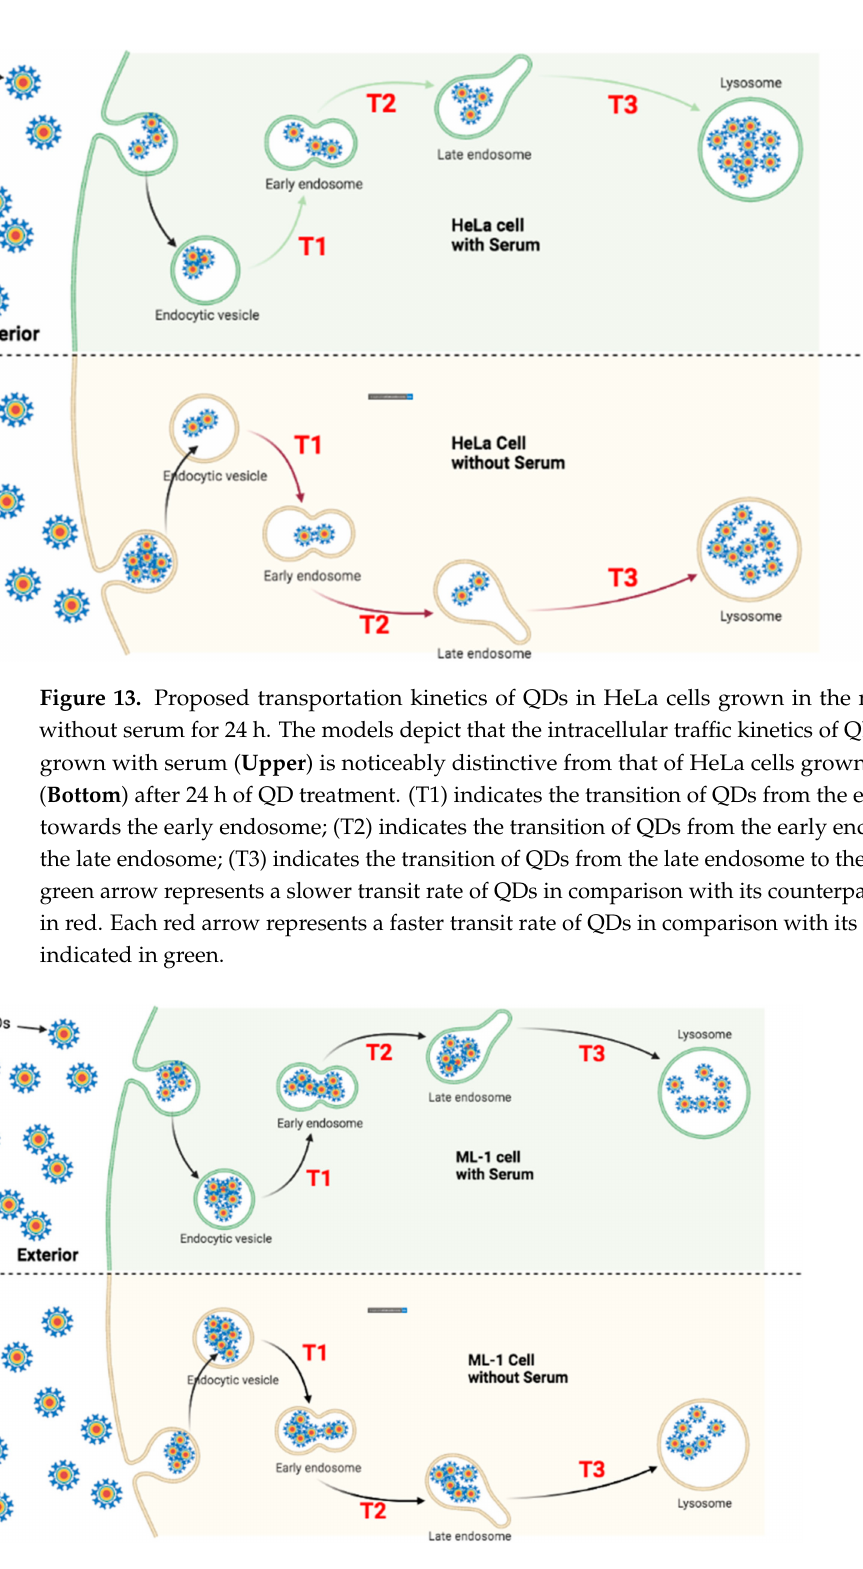
Figure 14. Proposed transportation kinetics of QDs in ML-1 cells grown in the media with and without serum for 24 h. The models depict that the intracellular traffic kinetics of QDs in ML-1 cells grown with serum ( Upper ) is noticeably distinctive from that of ML-1 cells grown without serum ( Bottom ) after 24 h of QD treatment. (T1) indicates the transition of QDs from the endocytic vesicle towards the early endosome; (T2) indicates the transition of QDs from the early endosome towards the late endosome; (T3) indicates the transition of QDs from the late endosome to the